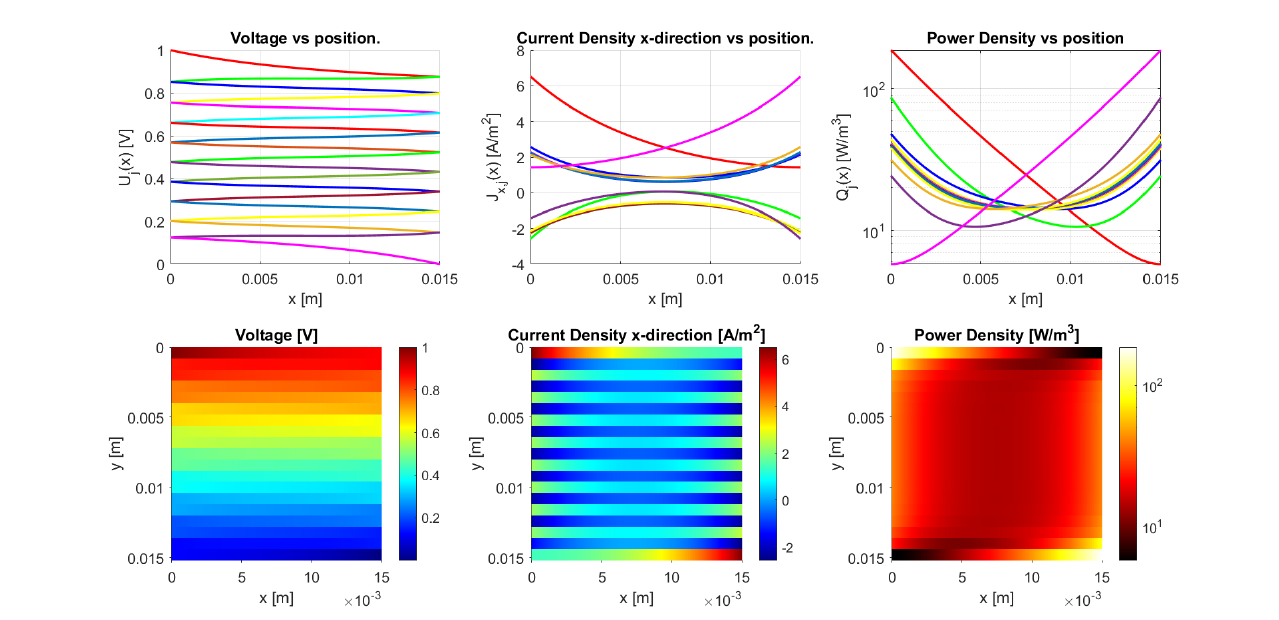
Figure 22. The model results for a meandering sample with the parameters from Table 2 and an inter-traxel resistance of σ = 2 × 10 − 1 Ω m 2 . This gives an anisotropy ratio of 0.0111, showing traxel conduction.